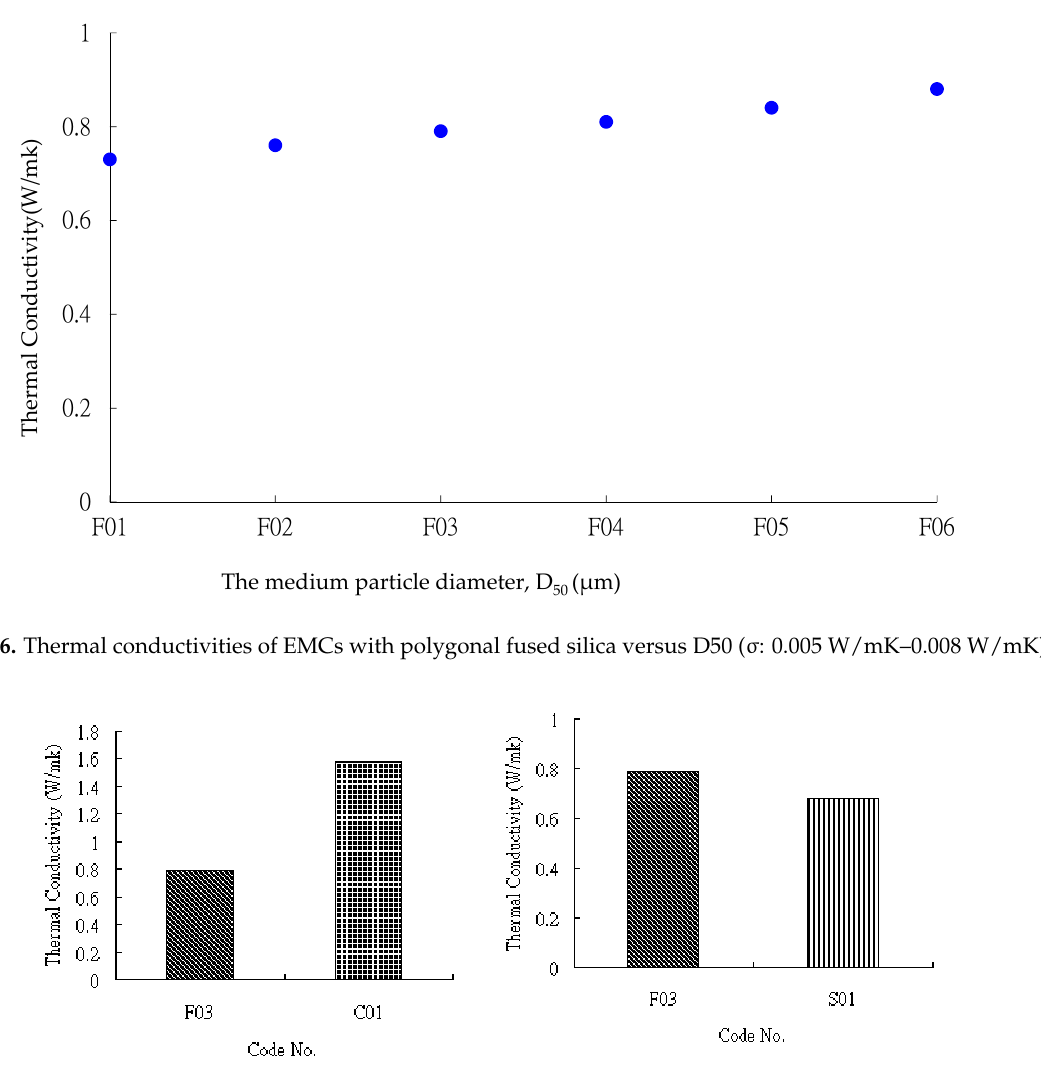
Figure 5. Shape feature of polygonal and spherical silica (scale bars are 4.34 and 5.88 µm for ( a ) and ( b ), respectively).